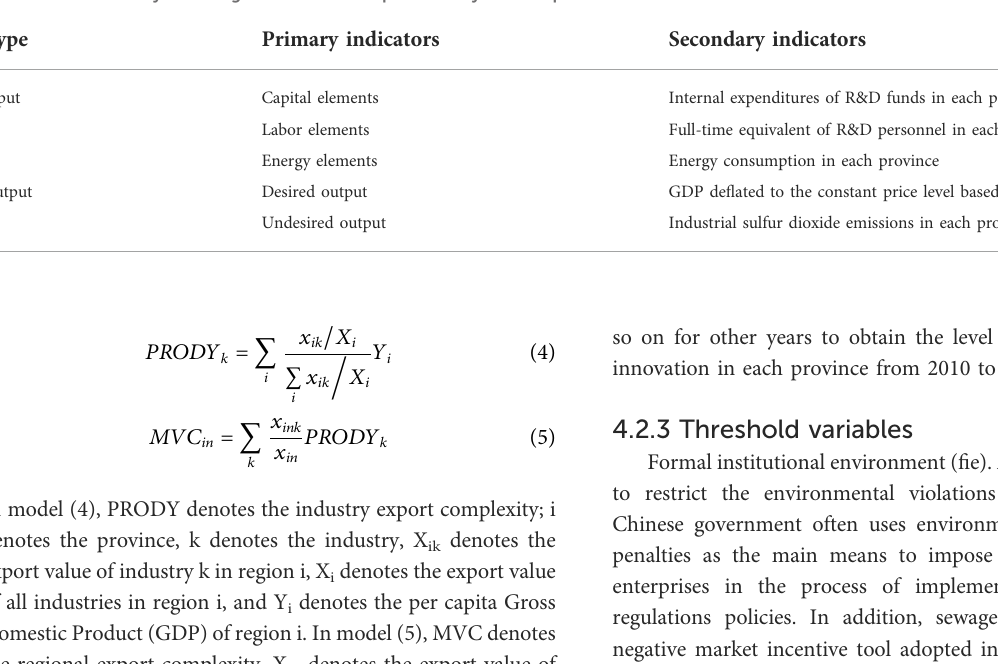
TABLE 1 Evaluation system of green total factor productivity in each